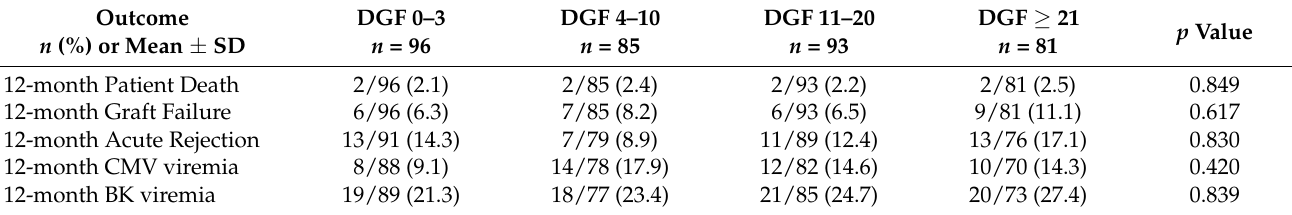
Table 4. Transplant recipient secondary outcomes stratified by DGF